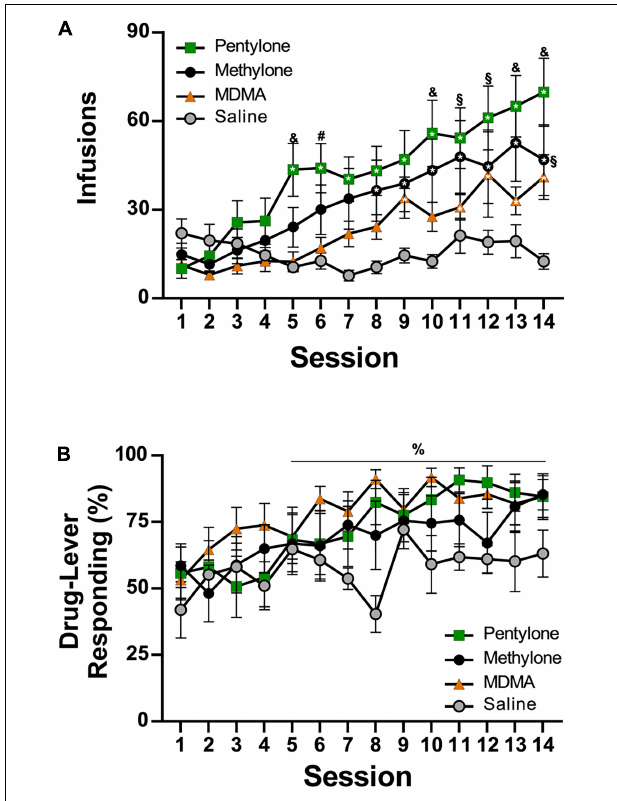
FIGURE 2 | (A) Mean ( ± S.E.M.) infusions of Pentylone ( N = 12), Methylone ( N = 10), MDMA ( N = 13), and saline ( N = 8; Vehicle) obtained under extended access conditions. (B) Mean ( ± S.E.M.) percent of responses on the drug-associated lever. A significant difference from the first session, within group, is indicated with *, a significant difference from the first session, collapsed across groups, with%, a difference from the Vehicle and MDMA groups with &, a difference from the Vehicle group with §, and a difference from the MDMA group with #.